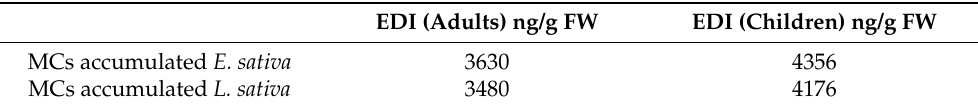
Table 4. Estimated daily MCs intake through food consumption of edible parts of two plants. ( µ g/kg/d). EDI (Adults) ng/g FW MCs accumulated E. sativa 3630 4356 MCs accumulated L. sativa 3480